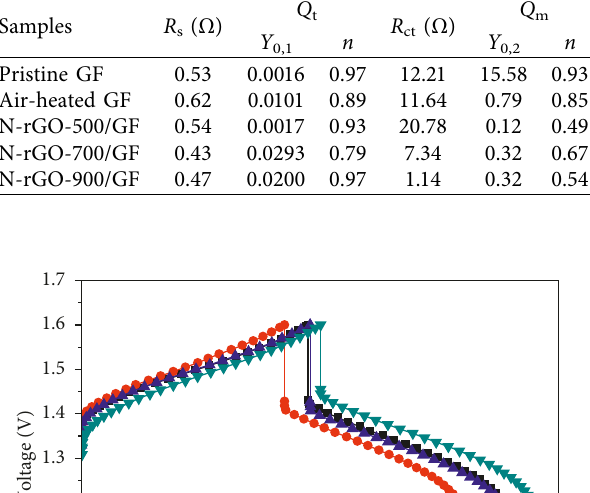
Figure 8: EIS spectra of different GF samples at the open-circuit potential. The fitted equivalent circuit is also plotted.